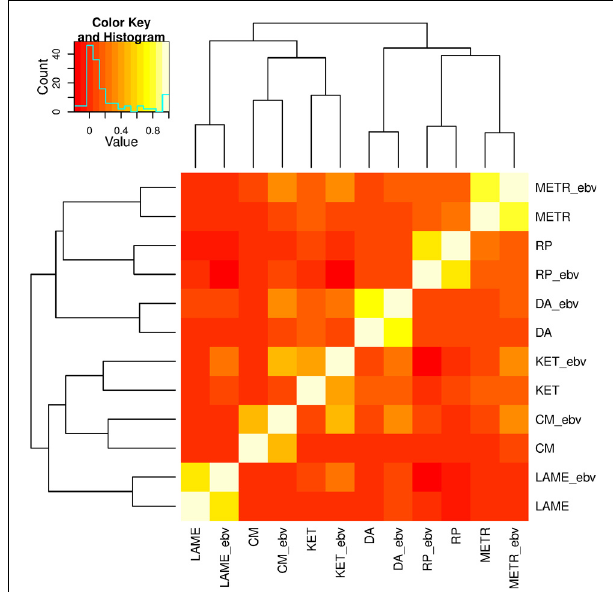
FIGURE 1 | Correlations among six health traits: ketosis (KET), displaced abomasum (DA), retained placenta (RP), lameness (LAME), metritis (METR), and clinical mastitis (CM). Variable names followed by "_ebv" denote estimated breeding values (EBV).